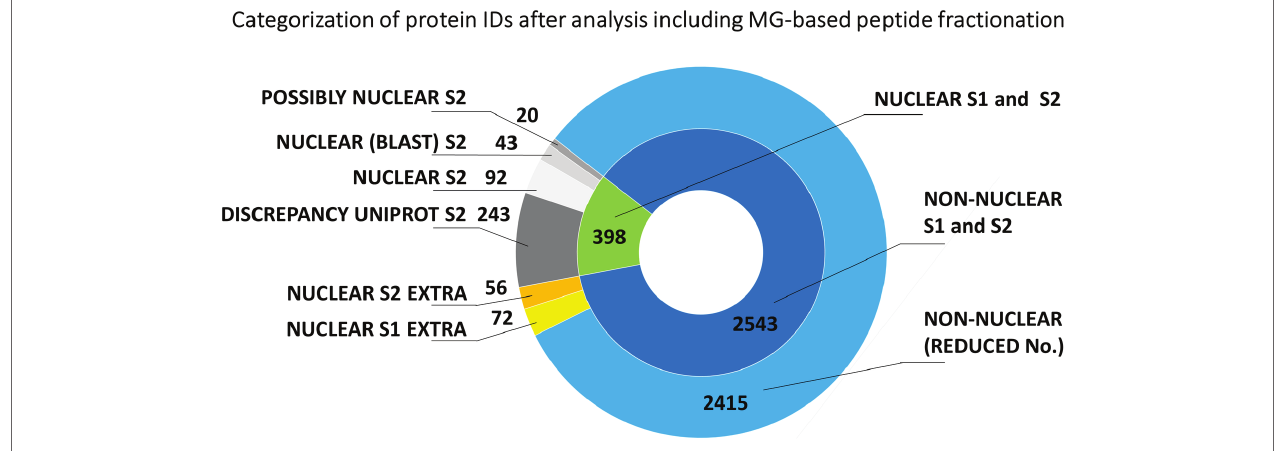
FIGURE 3 | Evaluation of the origin of proteins from mitotic chromosomes identified by nLC-ESI-Q-TOF MS/MS with MG fractionation of tryptic peptides. The nested pie chart shows information on the possible nuclear or non-nuclear localization of all identified proteins and their distribution into categories reflecting results of a two-round search approach (S1 and S2). The principle of S1 and S2 sorting is provided in Materials and Methods. See the legend to Figure 1 for elucidation of the attributed